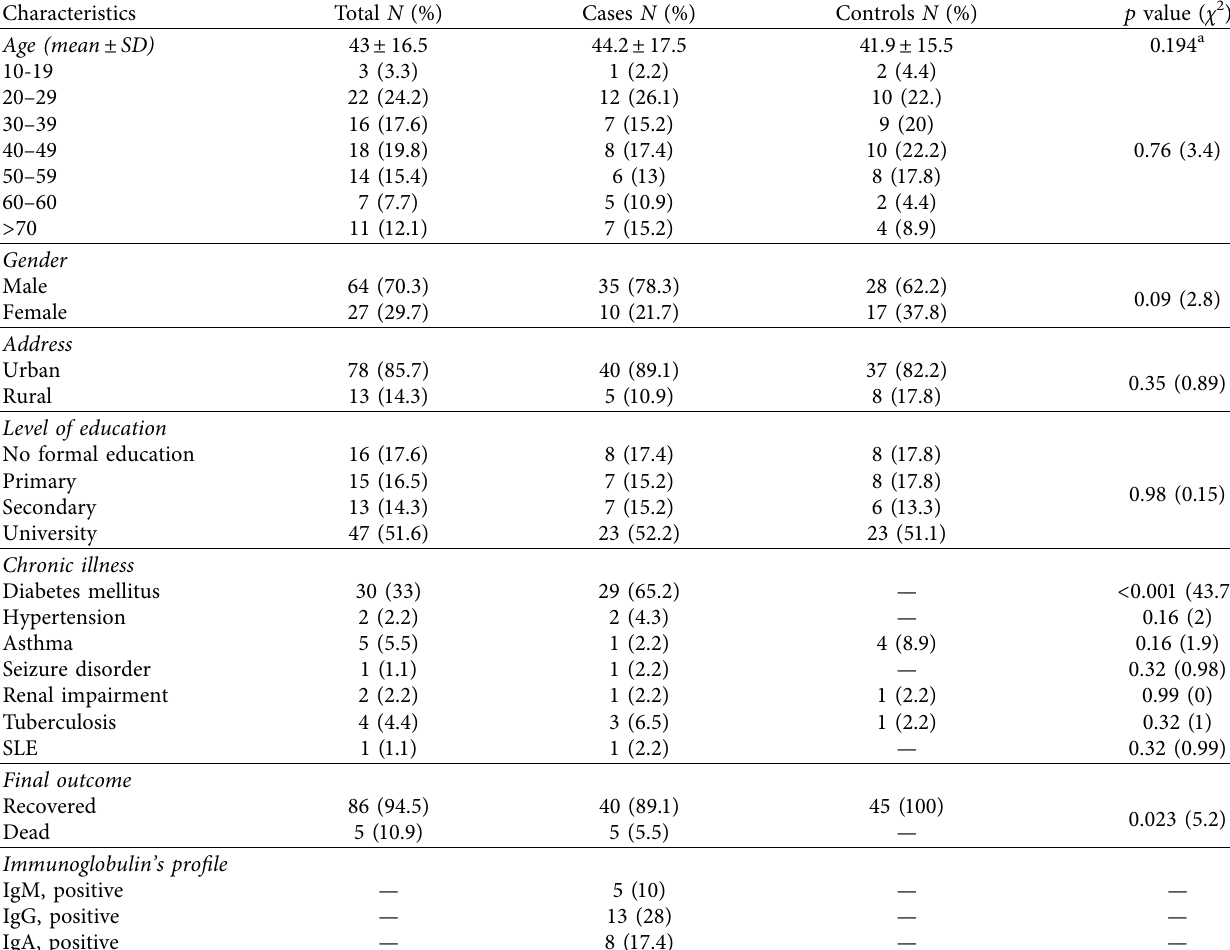
Table 1: Baseline sociodemographic characteristics of cases and